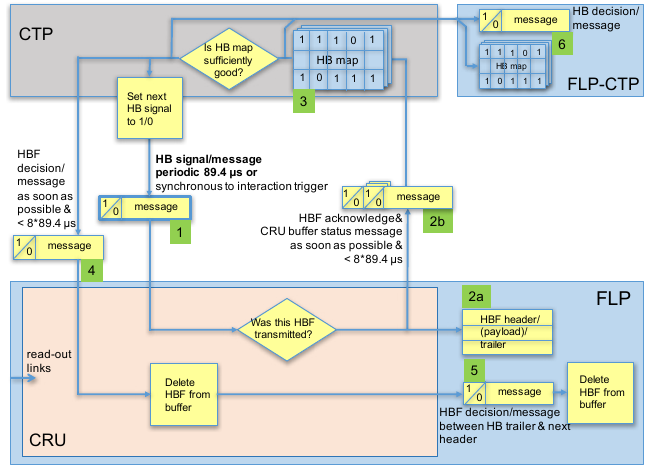
Figure 2. A logical flow of HeartBeat signals between CTP, CRU and